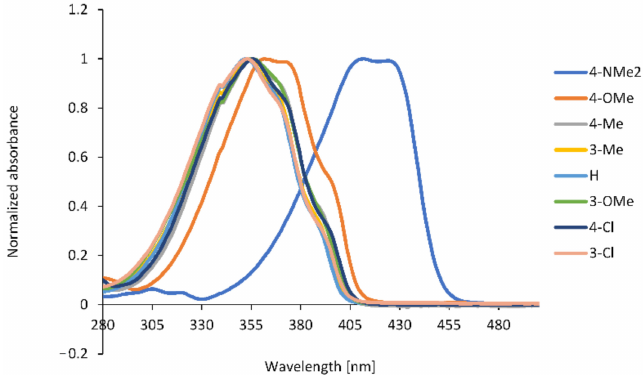
Figure 2. Normalized absorption spectra of 1 – 8 in chloroform (values were converted to have the maximum normalized at 1). Table 2. Photophysical properties of examined compounds measured in chloroform.